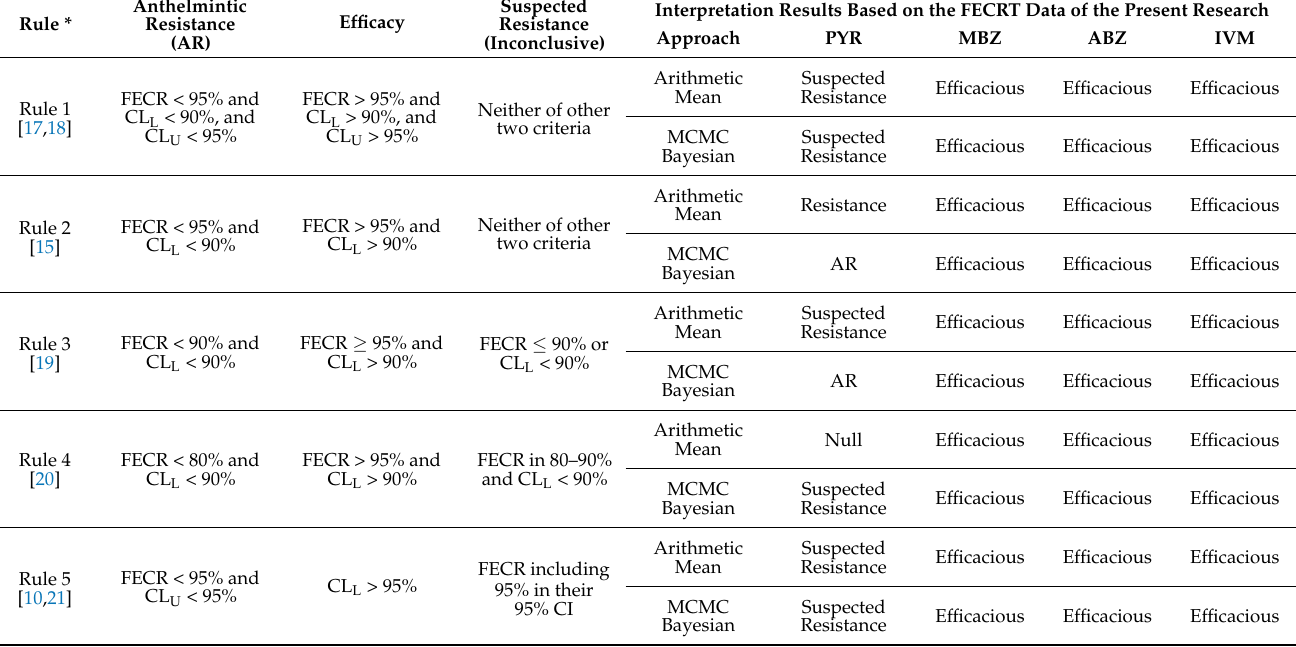
Table 3. The anthelmintic efficacy as assessed by the arithmetic mean and MAMC Bayesian approach with different